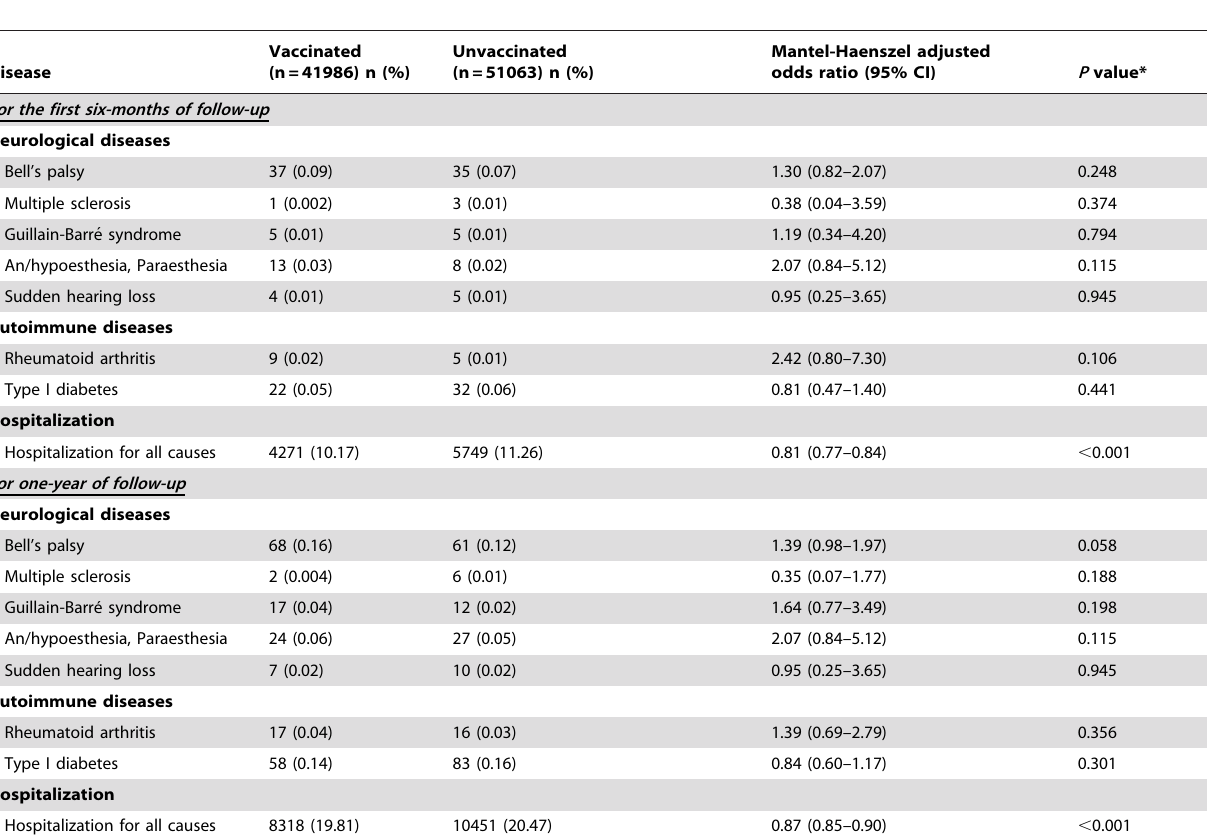
Table 4. Risk of selected neurological and autoimmune diseases and hospitalization in vaccinated versus unvaccinated groups